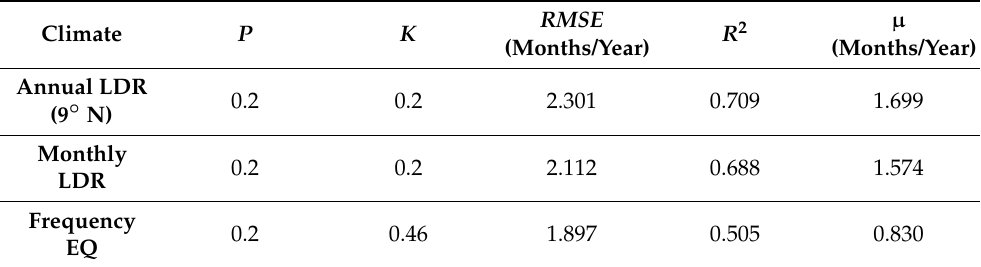
Figure 18. Focus of the LRR functions within the groin area (2 km) for the three different climate time resolutions analyzed. Table 5. Comparison of annual LDR-equivalent climate, monthly LDR-equivalent climate, and frequency-equivalent climate.